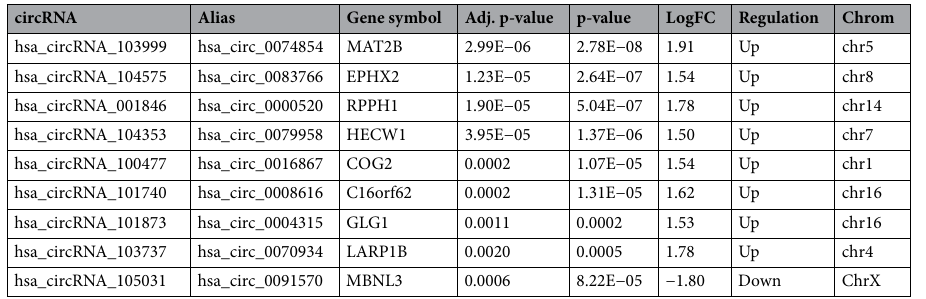
Table 3. Comprehensive information of nine